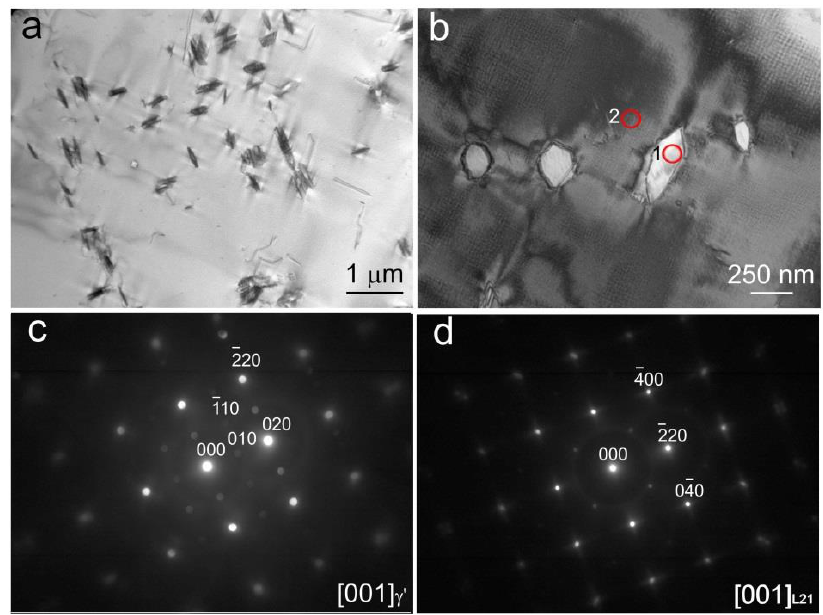
Figure 1. TEM image of the microstructure in the Ni 54 Fe 19 Ga 27 single crystals aged at 773 K for 1 h: bright field (BF) image of matrix and particles ( a , b ) and the selected area diffraction patterns from γ (cid:48) -phase particles with the ordered L1 2 structure (area 1 is indicated in b) ( c ) and L2 1 -austenite, zone axis [001] L21 (area 2 is indicated in b) ( d